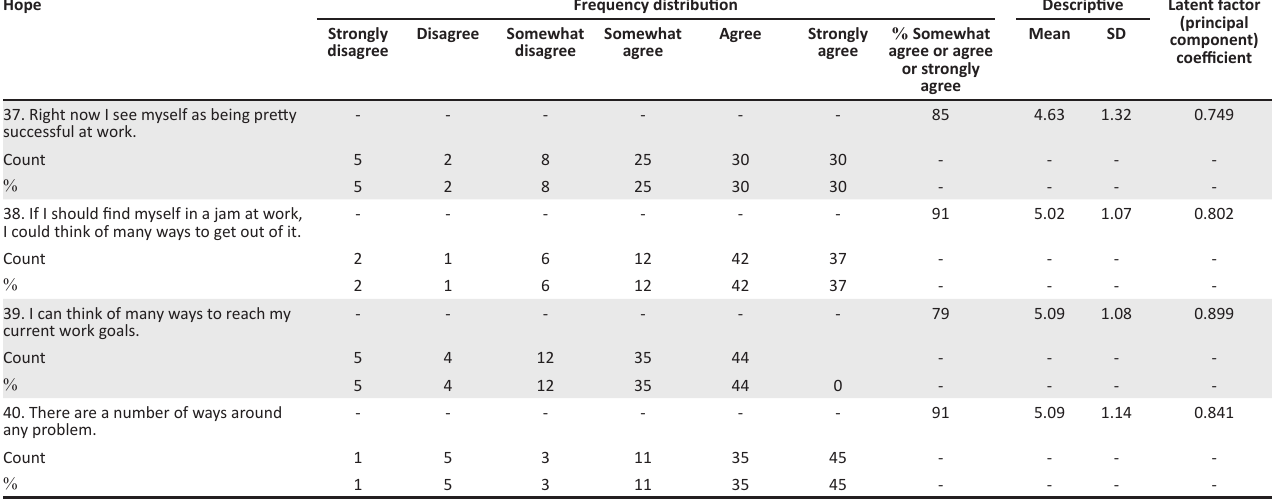
TABLE 11: Analysis of the construct of